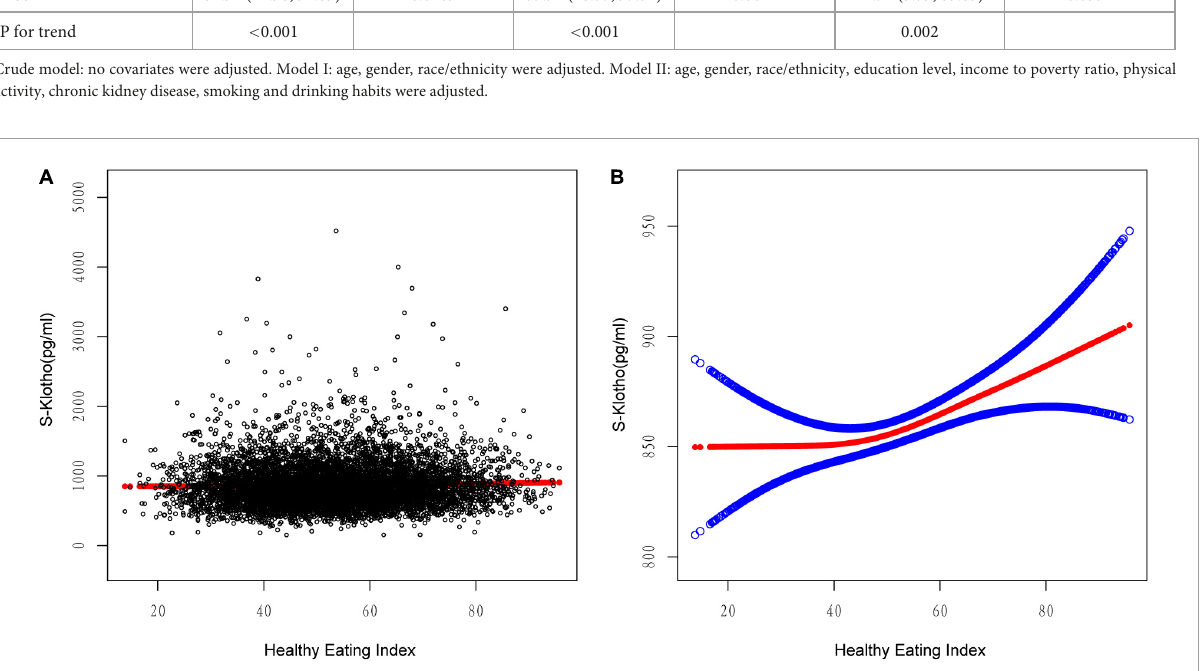
FIGURE1 Relationship between HEI-2015 and S-Klotho. (A) Each black dot represents A sample. (B) Solid lines represent smooth curve fitting between variables. The blue dashed line represents the fit’s 95% confidence interval. They controlled for calorie consumption, age, gender, race/ethnicity, education level, income to poverty ratio, physical activity, energy intake, chronic kidney disease, and smoking and drinking